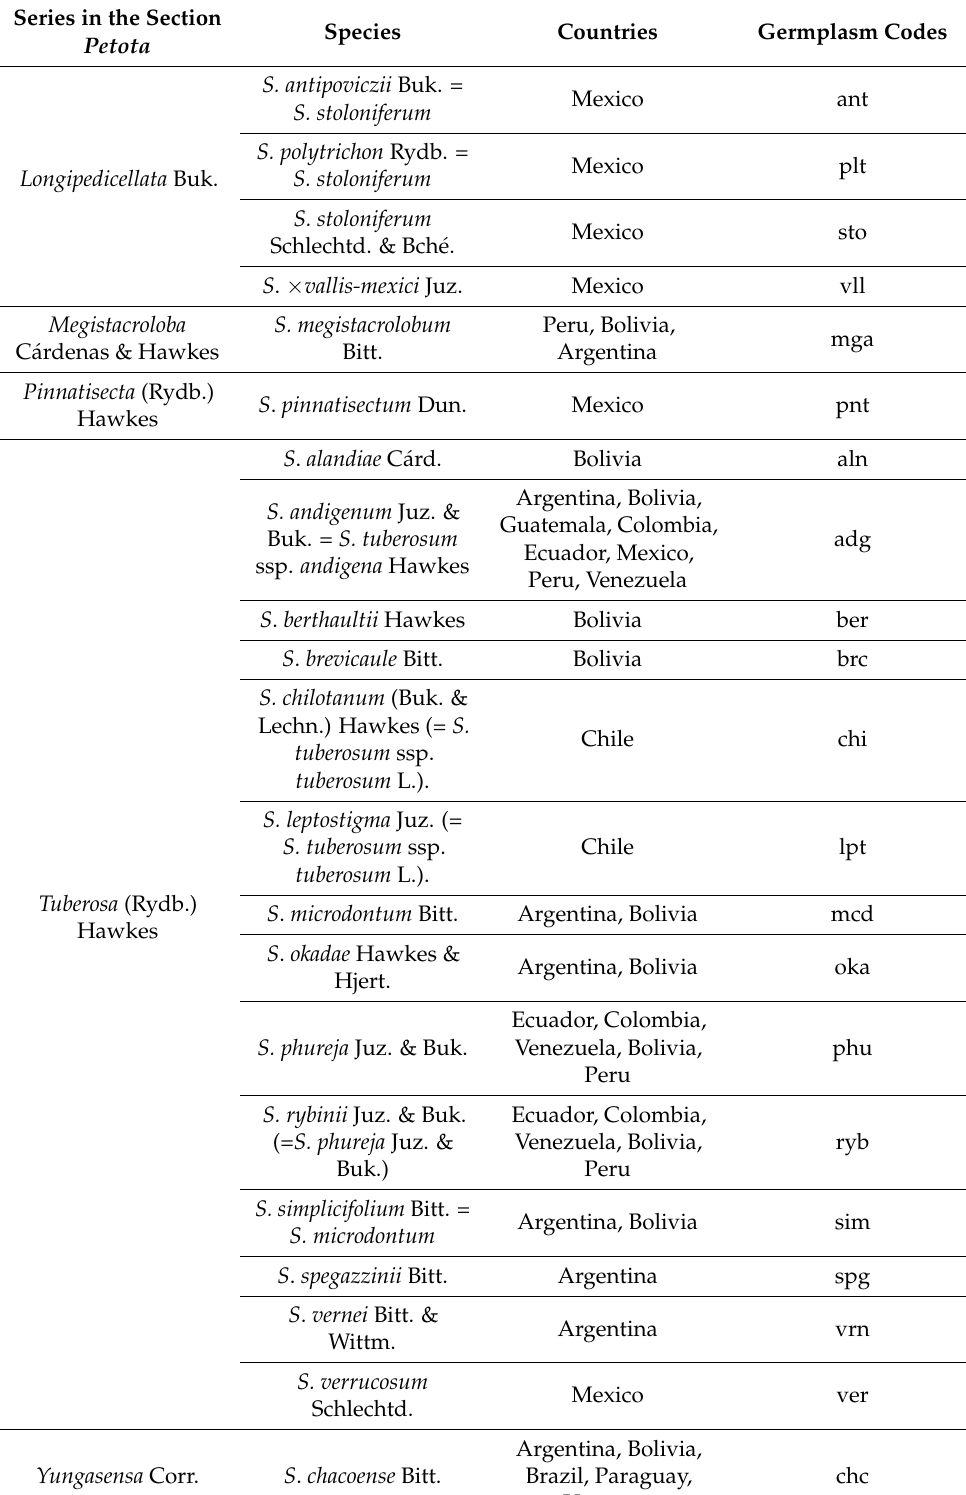
Table 1. Cont. Series in the Section Species Countries Germplasm Codes Petota